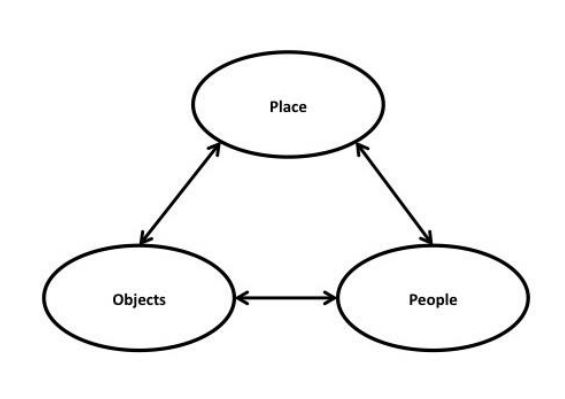
Figure 3. Relationship network of constructing the authenticity (Author’s elaboration from Jones, 2010)